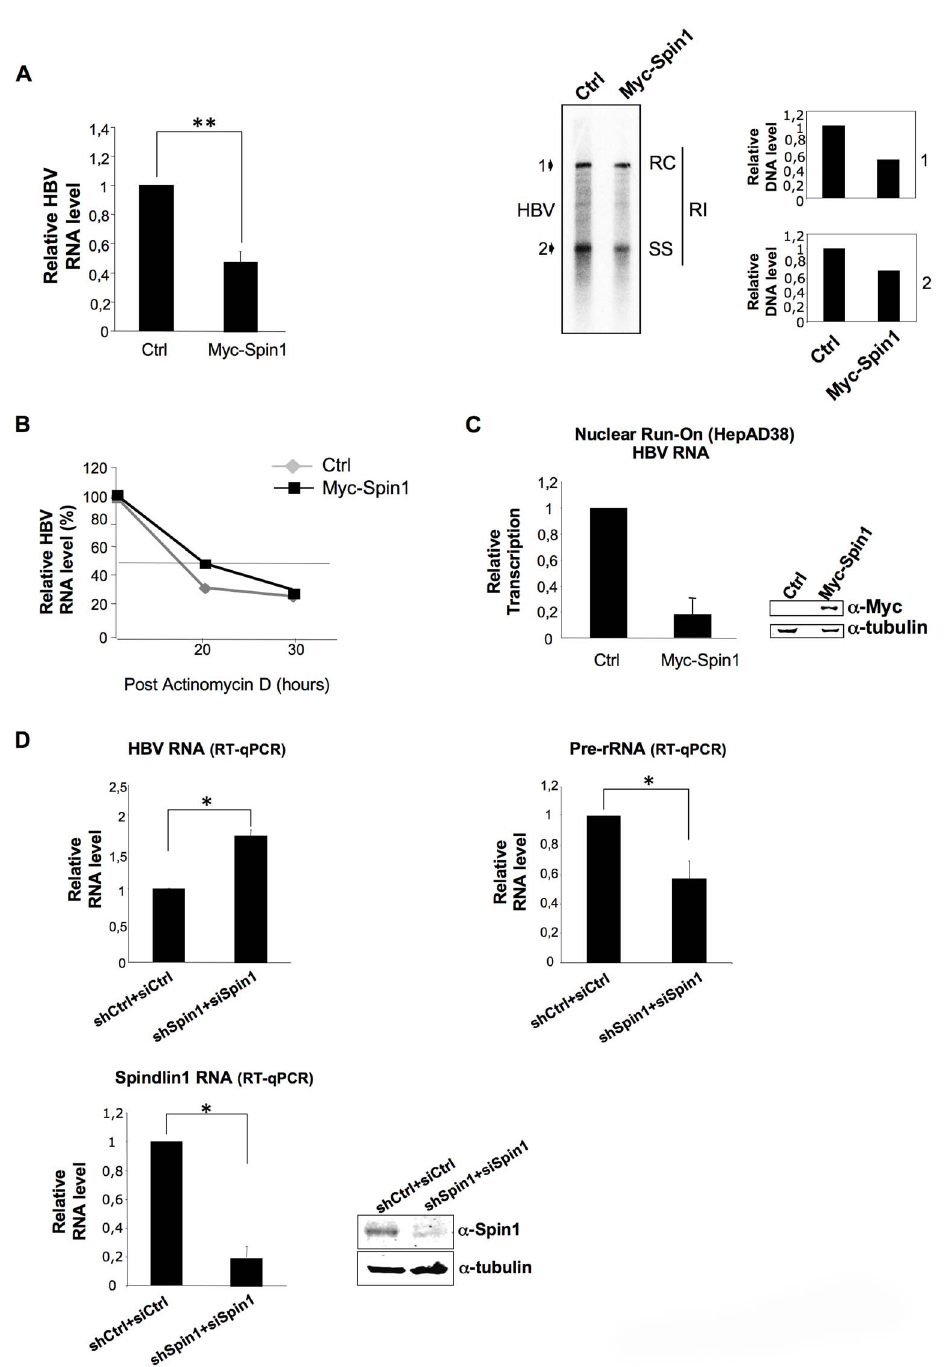
Figure 2. Spindlin1 represses HBV transcription in HepAD38 cells. ( A ) HepAD38 cells cultured without tetracycline were transduced with an empty lentiviral vector (Ctrl) or a lentiviral vector encoding His-Myc-Spindlin1 (Myc-Spin1). Cells were then harvested 48 h after transduction for total RNA extraction and HBV transcription was analyzed by RT-qPCR (left graph). Transcript level in cells transduced with the empty lentiviral vector was set to 1. P values were determined by Wilcoxon test (**, P =0.007). Error bars represent SD of eight independent experiments. Alternatively, cells were harvested 72 h after transduction and capsid-associated DNA was extracted. The replication intermediates were then analyzed by southern blot. RC: relaxed circular DNA, SS: single-stranded DNA, RI: replication intermediates. The relative intensities of RC DNA (1) and SS DNA (2) were quantified. The results are presented on the right graphs. The intensity in the control condition was set at 1. ( B ) Spindlin1 does not affect HBV RNA stability. HepAD38 cultured without tetracycline were transduced as in (A). After 48 h, the cells were treated with actinomycin D (5 m g/ml) that blocks polymerase II. Cells were collected at the indicated times after treatment and total RNA was prepared. HBV RNAs were then quantified by RT-qPCR. The relative level of HBV transcription was normalized with Roth2 gene. The amount of RNA at time zero was set at 100%. ( C ) Spindlin1 modulates the rate of HBV transcription. Nuclear run-on assays were performed on isolated nuclei from HepaAD38 cells transduced as in (A). Transcripts generated during run- on were purified using anti-BrdU beads and HBV RNAs were quantified by RT-qPCR. Transcript level in cells transduced with the empty lentiviral vector was set to 1. Error bars represent SD of three independent experiments. The expression of His-Myc-Spin1 was analyzed by immunoblot with